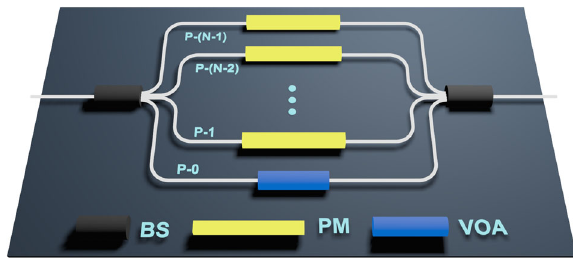
Fig. 2 The structure of our multipath Mach-Zehnder interferom- eter. In this modulator, input pulses are split by an 1 × N splitter and enter into N different paths. The path-0 has a VOA to attenuate the pulse and the path-1 to N − 1 each has a phase modulator to modulate the relative phases. Finally, the split pulses interfere in a N × 1 coupler. P path; BS beam splitter; PM phase modulator; VOA variable optical